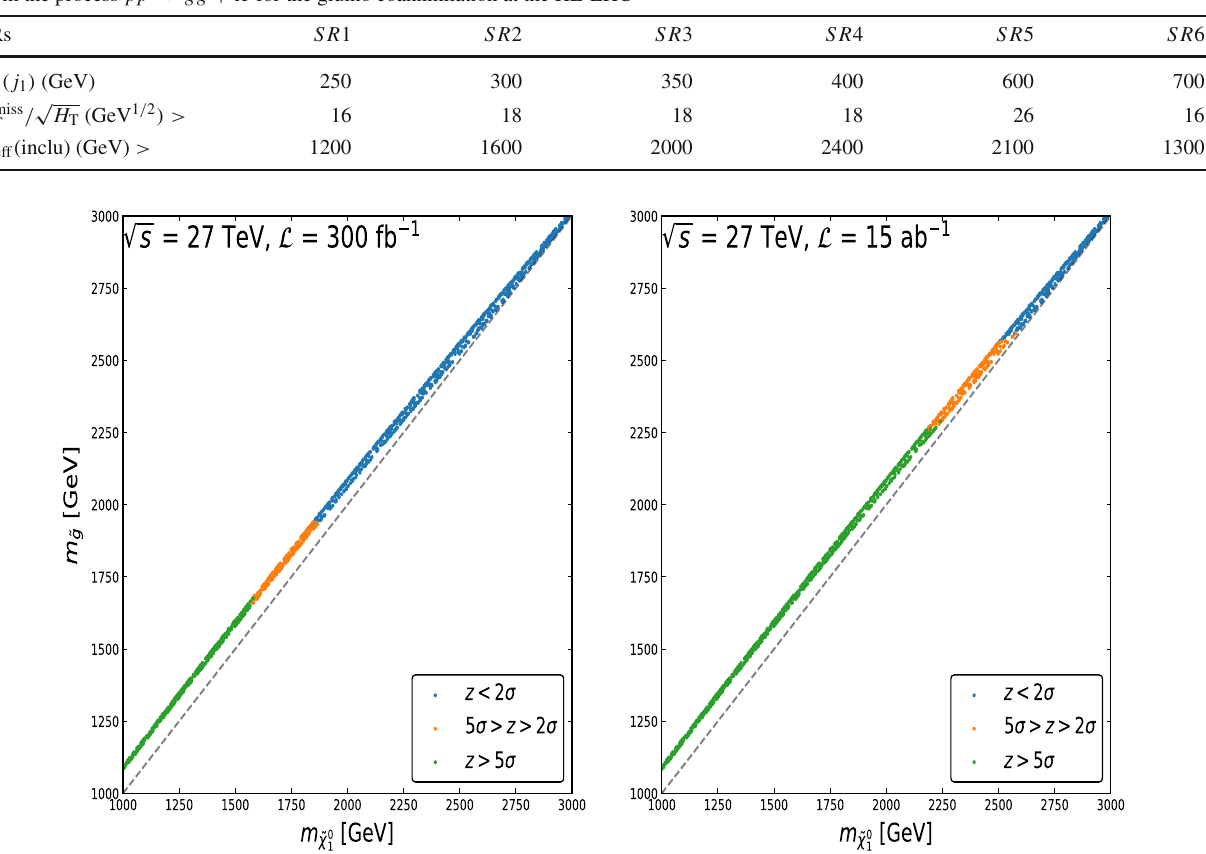
√ / H T in the multijet plus missing transverse energy events T